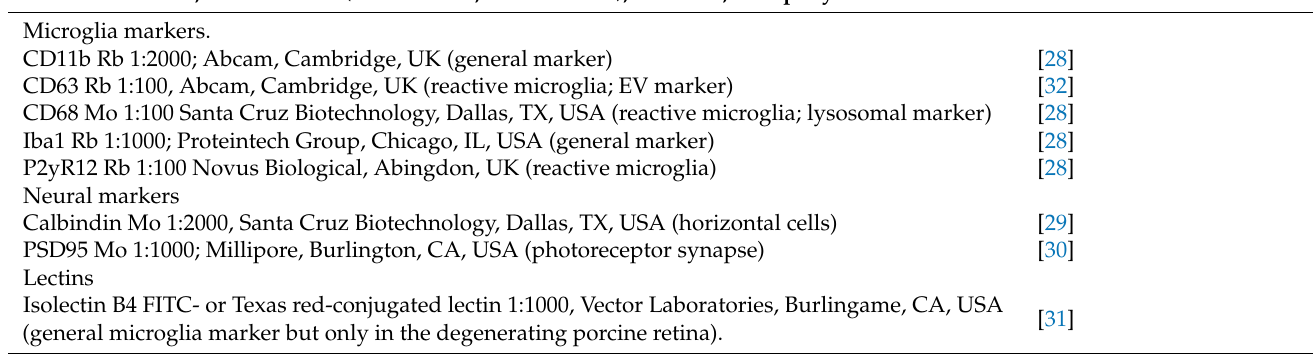
Table 1. Antibodies and